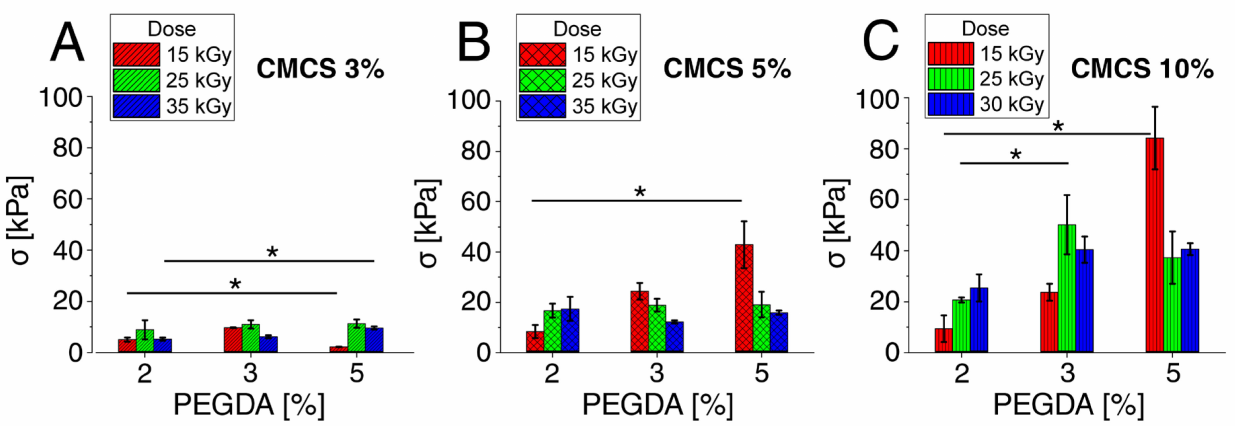
Figure 4. Maximum compressive strength (kPa) for hydrogels with various PEGDA and radiation doses for ( A ) CMCS 3%, ( B ) CMCS 5%, and ( C ) CMCS 10%. The p -values of the post hoc test are provided; p < 0.05 (*). Measurements were made at room temperature (~25 ◦